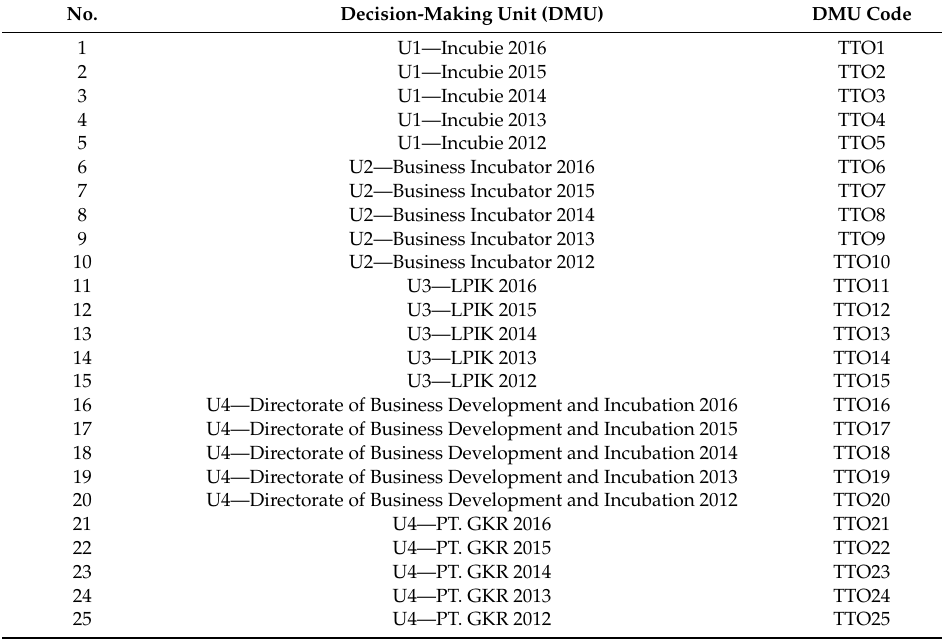
Table 5. List of DMU